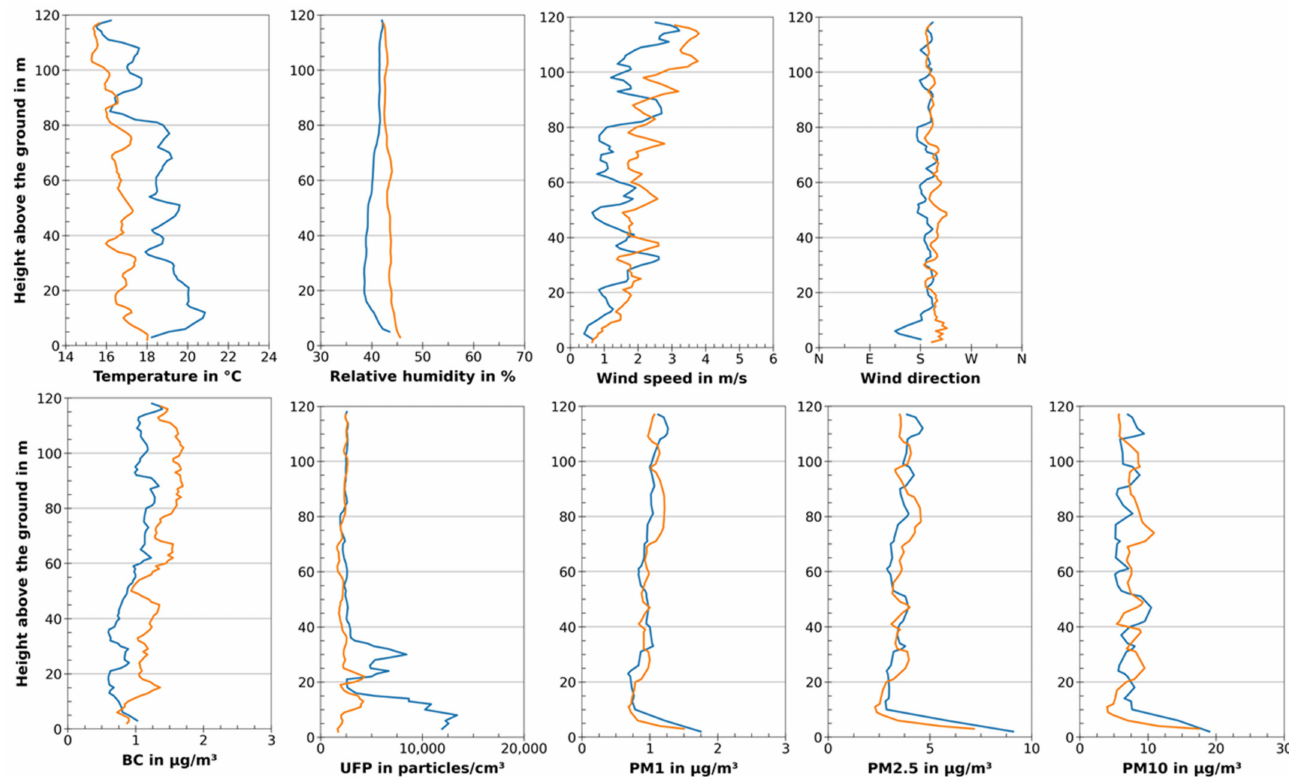
Figure 12. Vertical profiles (ascent: blue line; descent: orange line) of the meteorological parameters and air pollutants during the flight at 11:14 on 23 January